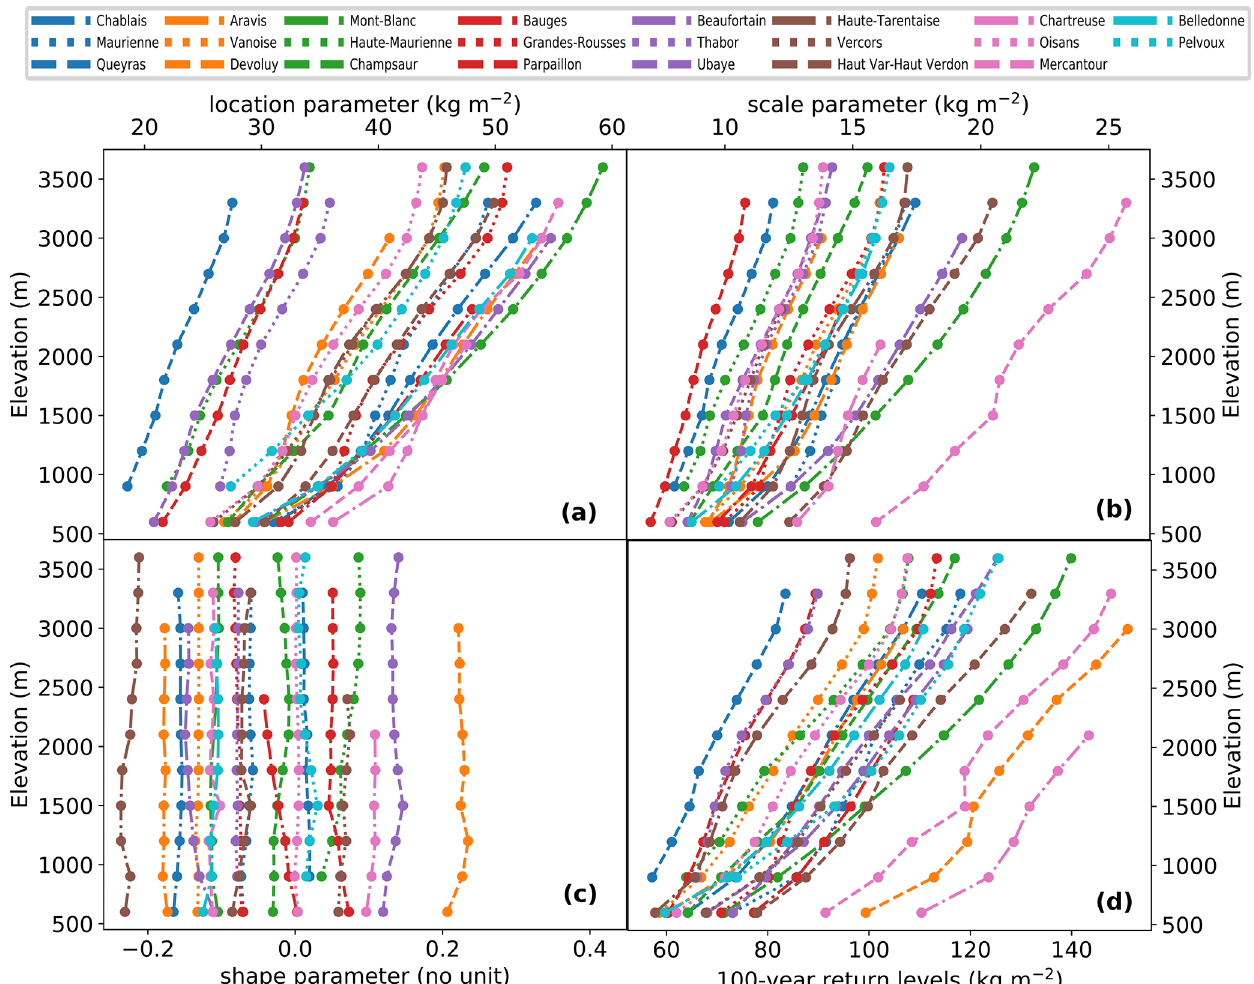
Figure D1. Changes in GEV parameters (a–c) and in 100-year return levels (d) with the elevation for the 23 massifs of the French Alps. GEV distributions are estimated pointwise for the annual maxima of daily winter precipitation every 300m of